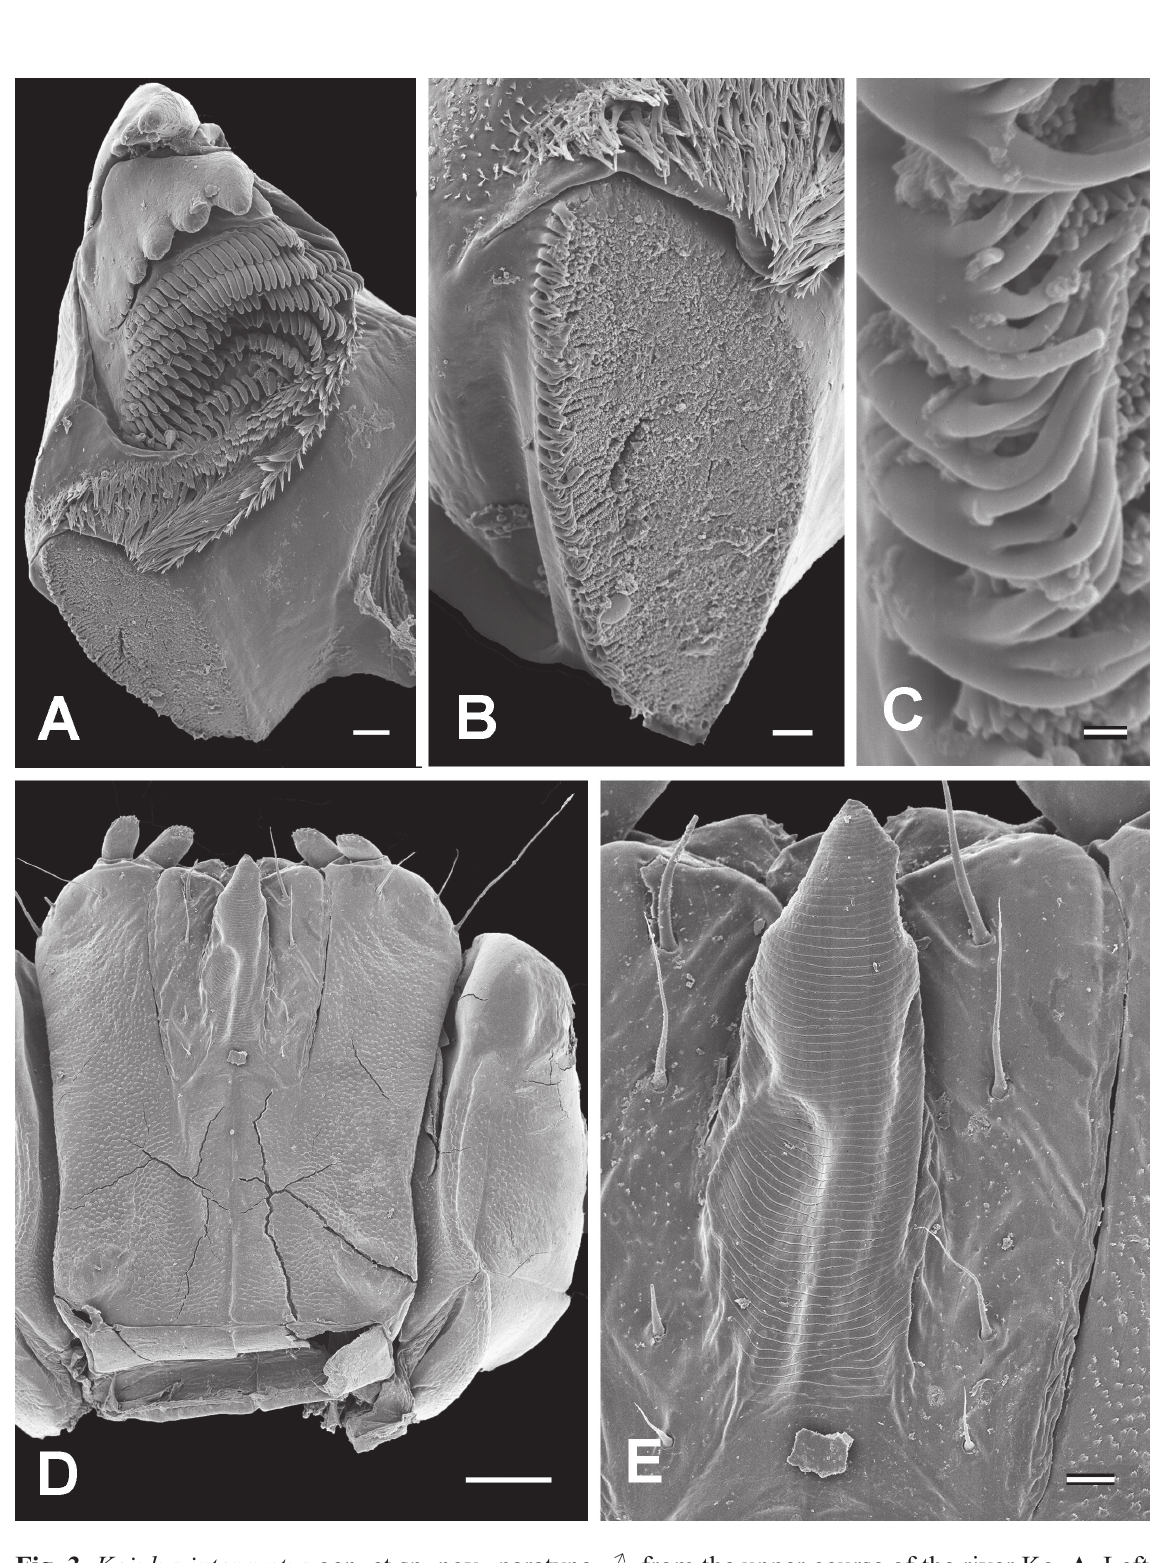
Fig. 3. Koiulus interruptus gen. et sp. nov., paratype, ♂, from the upper course of the river Ko. A . Left mandible. B . Molar plate of left mandible. C . Handlike processes on anterior margin of molar plate. D . Gnathochilarium. E . Lamellae linguales and modified promentum of gnathochilarium. Scale bars: A, E = 0.02 mm; B = 0.01 mm; C = 0.001 mm; D = 0.1